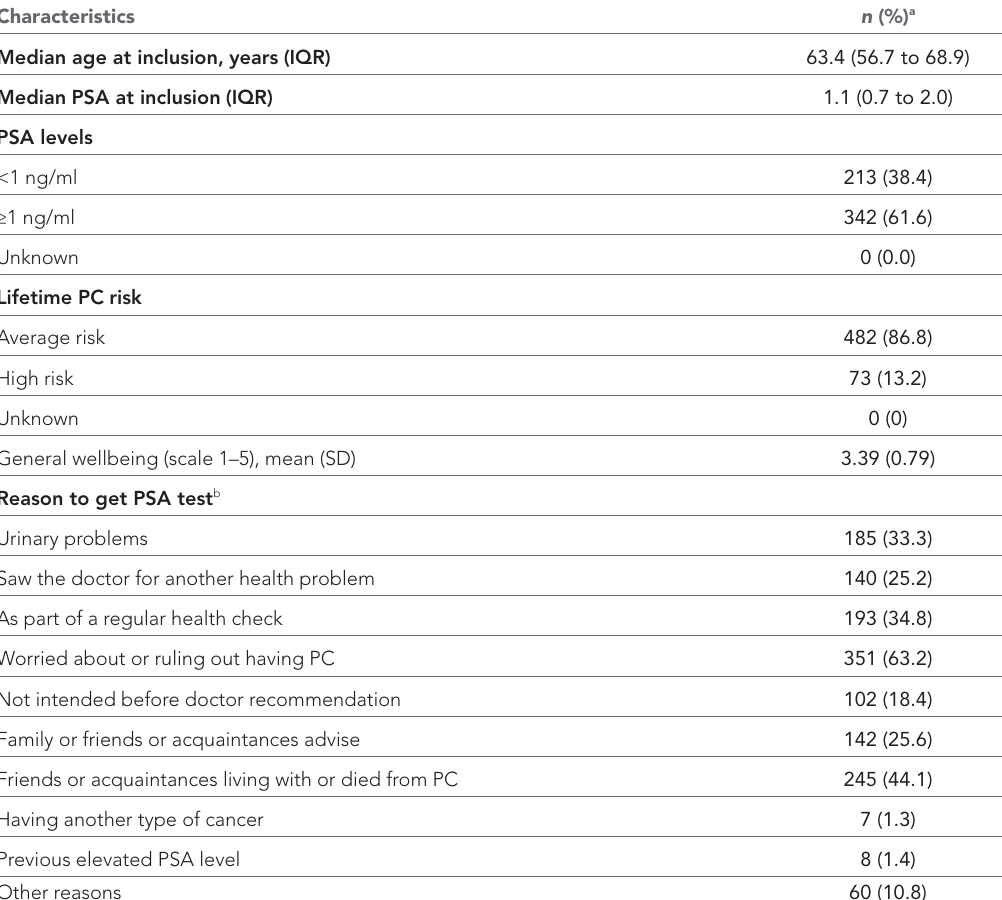
Table 2 Summary of patient characteristics ( N = 555)